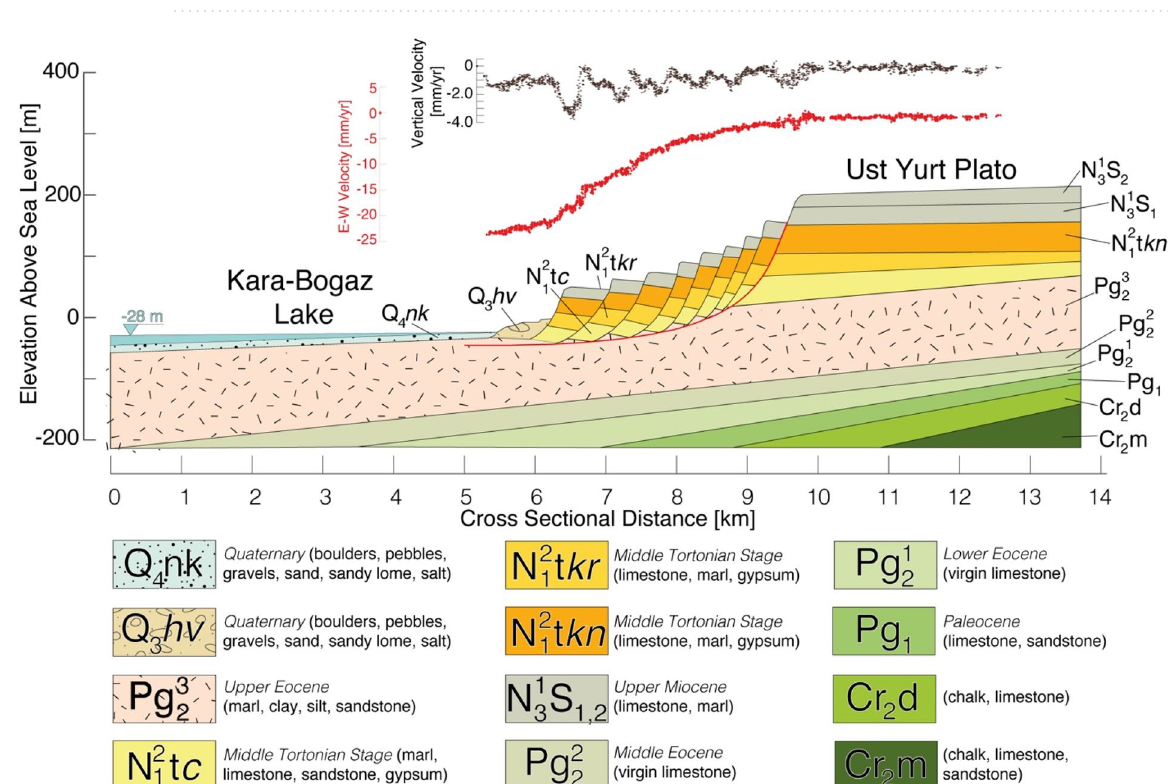
Figure 6. Schematic diagram of the geological cross-section (A–B) of the landslide including horizontal (red) and vertical (black) velocities. The geological map, cross-section, and lithological descriptions were obtained from the OneGeology Platform (http:// www. onege ology. org). Line A–B in Fig. 1c shows the profile location. This figure was created with Adobe Illustrator CS6 ver. 16 (http:// www. adobe. com/ produ cts/ illus trator.